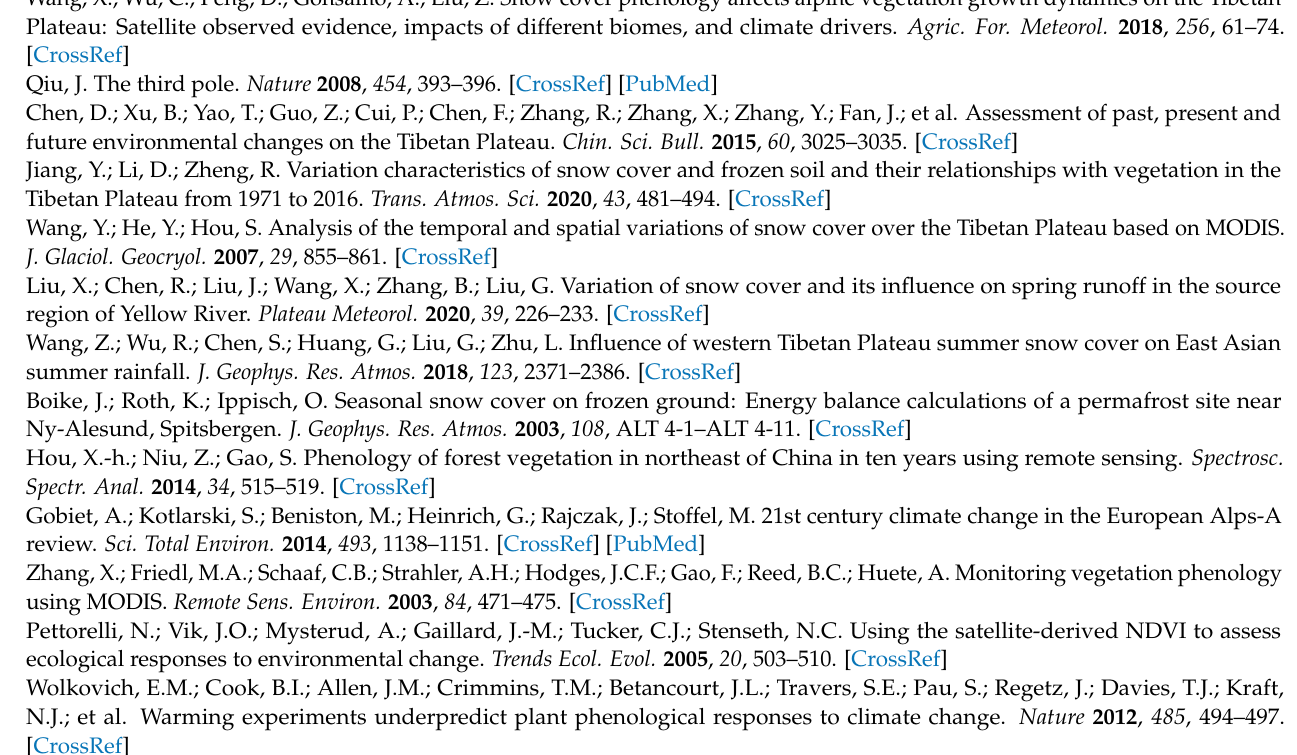
Figure S3: The interannual trend of the snow cover phenology (SCOD, SCED, SCD, and SMOD) during 2003–2020; Figure S4: Spatial distribution of Pearson’s correlation coefficient between the GUD and four snow cover phenology